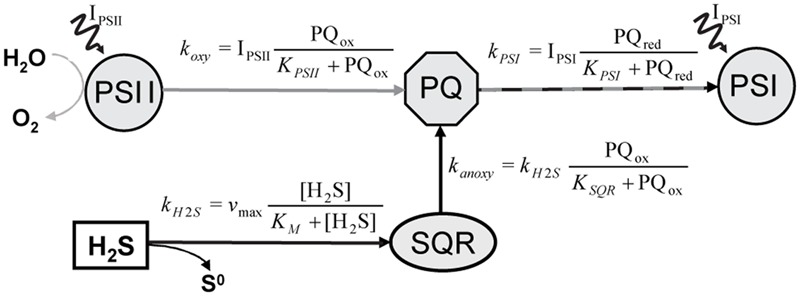
Simplified diagram of the model describing partitioning between AP and OP in versatile cyanobacteria, as proposed by Klatt et al. (2015a). The AP and OP pathways intersect at plastoquinone (PQ) and their partitioning is regulated by the PQ redox state. In the AP pathway, PQ is reduced in a light-independent reaction by the enzyme sulfide:quinone:reductase (SQR), which obtains the electrons from the oxidation of H2S to zero-valent sulfur. In contrast, PQ reduction in the OP pathway is driven by the light-dependent activity of photosystem II (PSII), with electrons originating from the oxidation of H2O to O2. In both pathways PQ oxidation is driven by the light-dependent activity of photosystem I (PSI). IPSI and IPSII denote light energy harvested in PSI and PSII, respectively. The rate-laws describing the kinetic regulation of the rates of OP (koxy), AP (kanoxy), H2S oxidation by SQR (kH2S) and of the total photosynthetic electron transport (kPSI) are shown by the formulae.